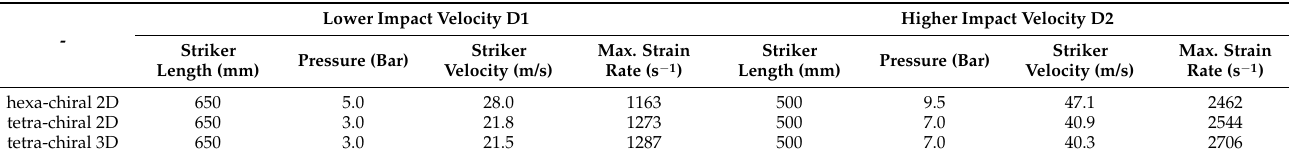
Table 3. The average dynamic impact testing data.